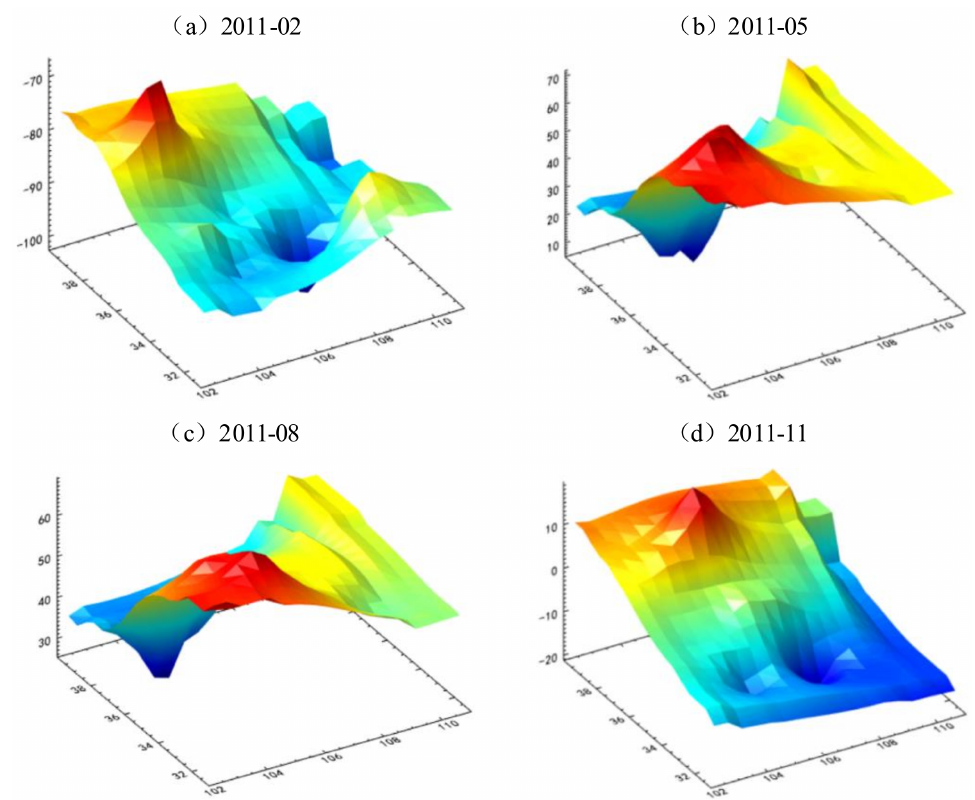
Figure 13. Residual grid map of regional GWS variations obtained by Kriging interpolation